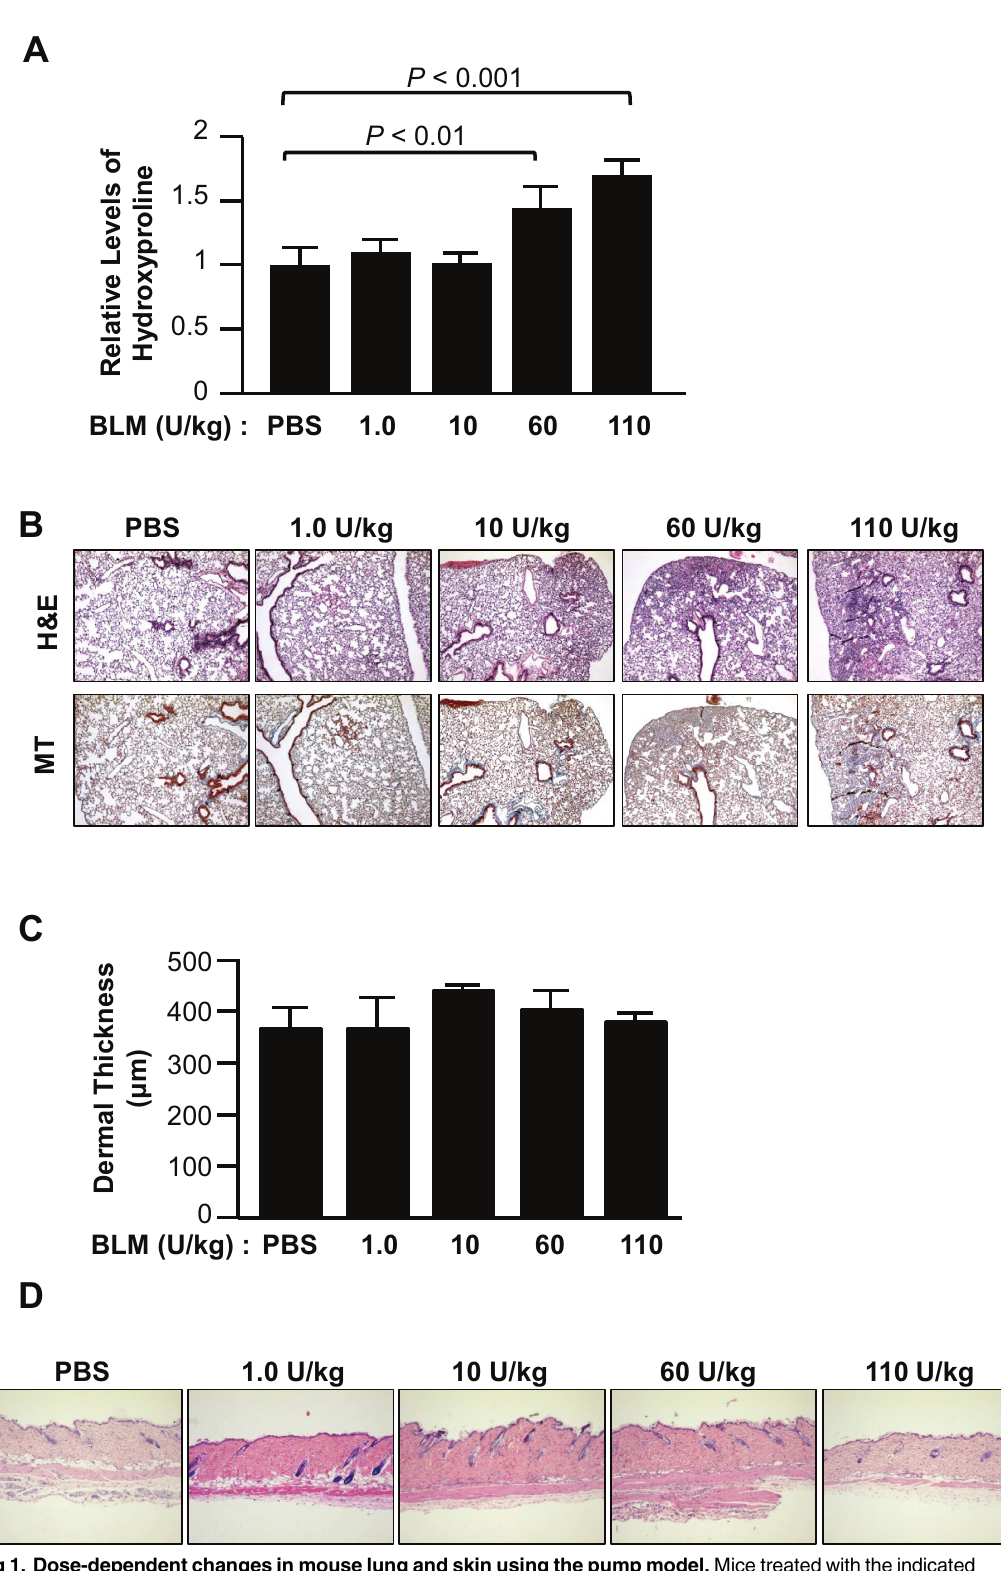
Fig 1. Dose-dependent changes in mouse lung and skin using the pump model. Mice treated with the indicated doses of BLM were sacrificedon day 28. (A) The amount of collagenin the lungs was quantified using